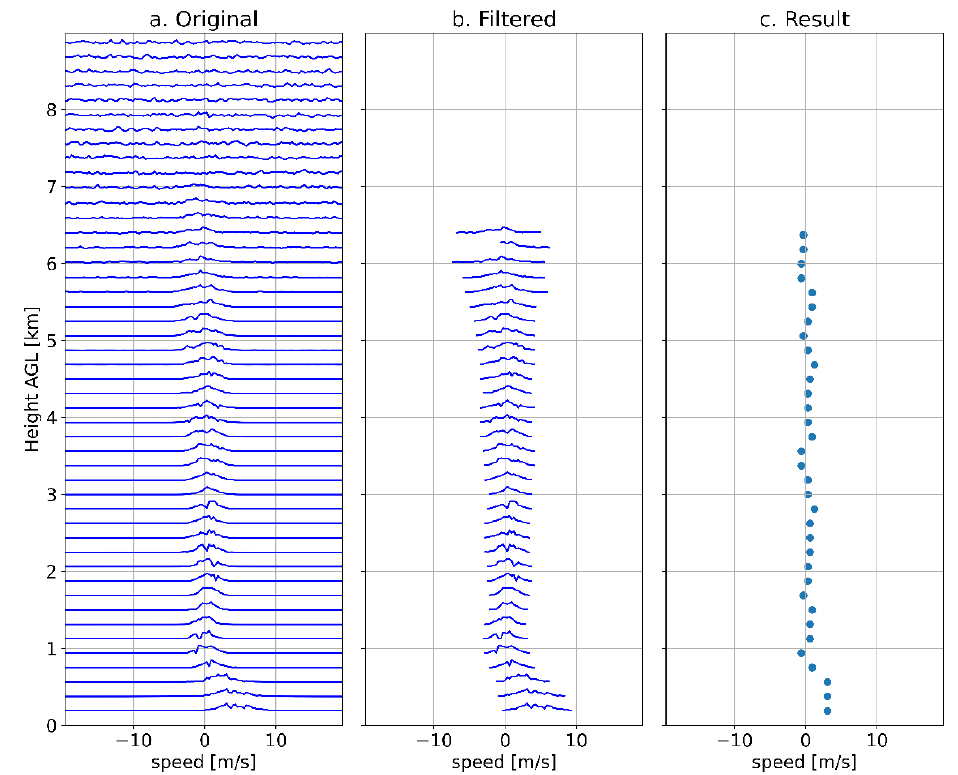
Figure 5. Example of Doppler speed profile corrected with the RWP vertical continuity test: ( a ) original signal, normalized, at each height; ( b ) signal after the peak detection was performed; ( c ) mean vertical speed for each height after applying the vertical continuity test. Data corresponds to Beam number 1 (vertical incidence, positive values corresponding to downward movement) recorded on the 25th of March 2017 3:01:44 UTC.